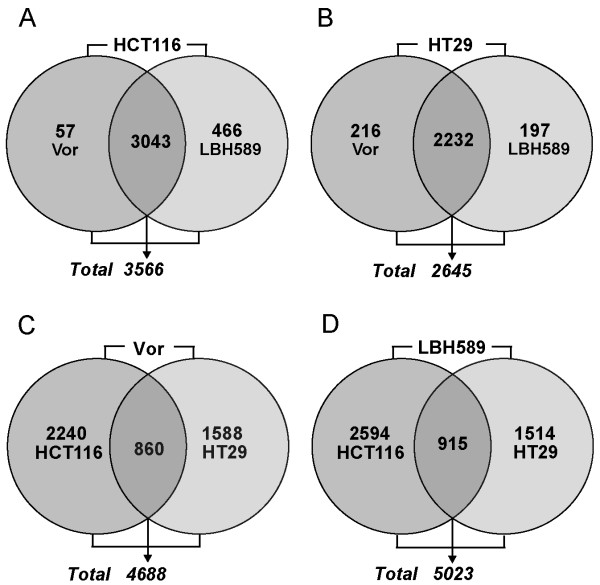
Venn analysis of differentially expressed genes in vorinostat and LBH589-treated HCT116 and HT29 colon cancer cells. HCT116 and HT29 cells were treated with either 2 μM vorinostat or 50 nM LBH589 for 24 h and gene expression analyzed on the Illumina Human-6 V2 BeadChip array. Genes with an FDR-adjusted p-value of < 0.05 were considered differentially expressed and subjected to Venn analysis. Venn analysis was first performed by analyzing cell-line-specific alterations in each individual cell line; (A) HCT116 cells treated with vorinostat or LBH589. (B) HT29 cells treated with vorinostat or LBH589. Subsequent Venn analysis demonstrates the drug-specific alterations induced by (C) vorinostat (Vor) and (D) LBH589 in both cell lines. Numbers within each circle represent the total number of genes modulated in that experimental condition, the numbers immediately below each Venn diagram indicate the total number of modulated genes by both experimental conditions in that Venn diagram.